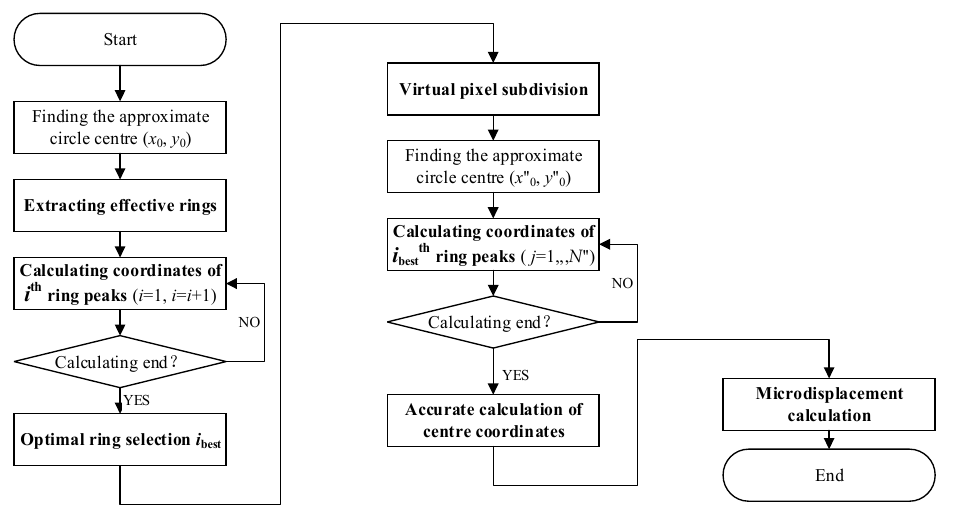
Figure 3. The flow chart of the data processing process.